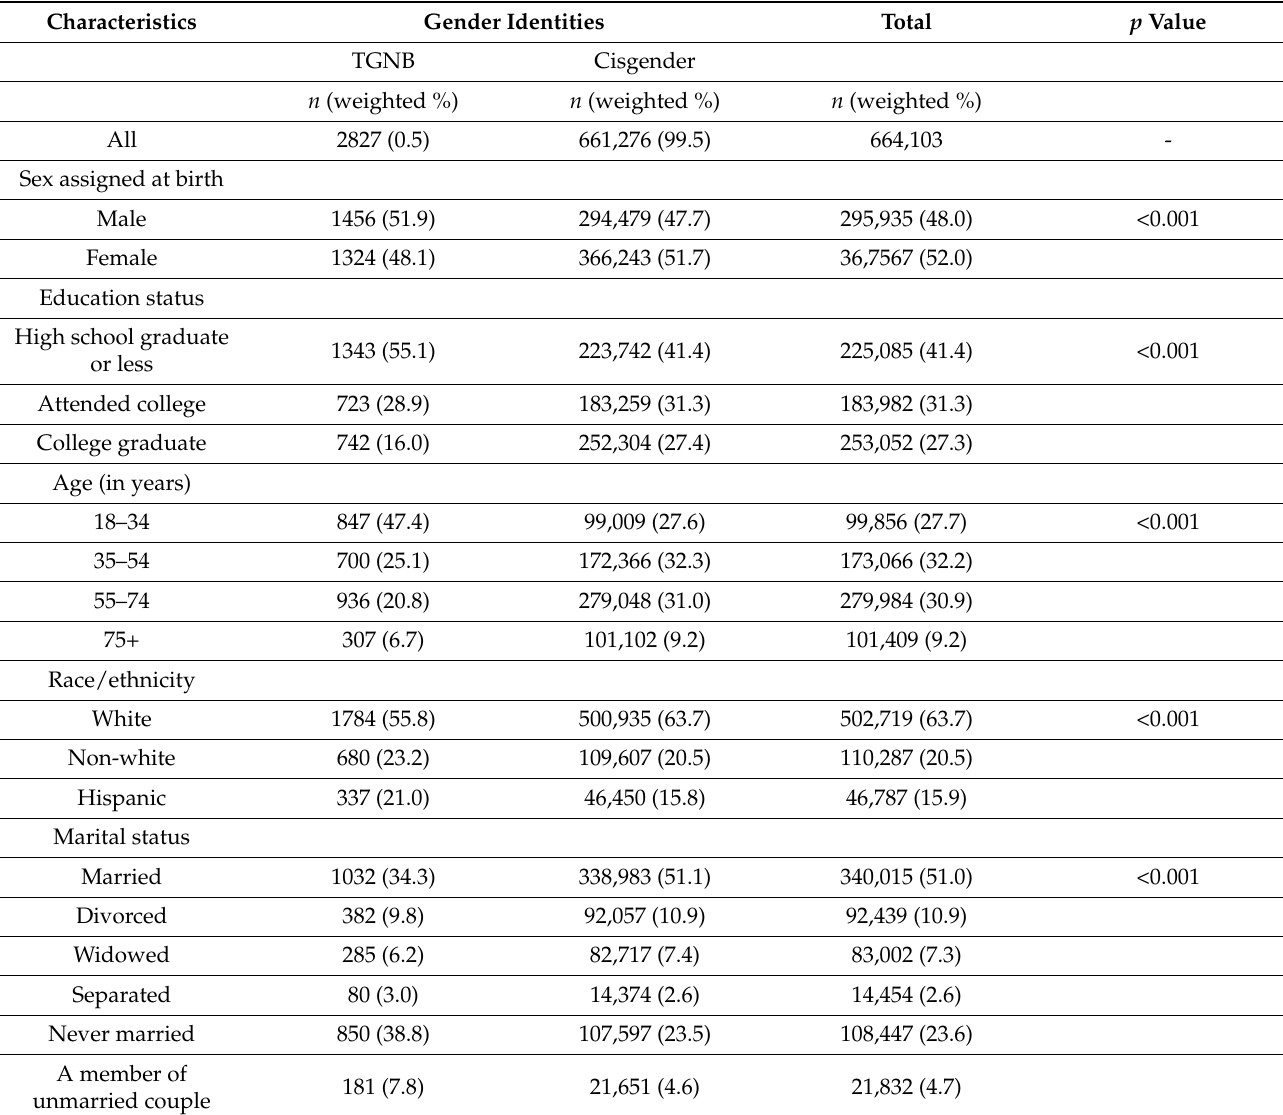
Table 1. Demographic characteristics of the unmatched study population ( N =